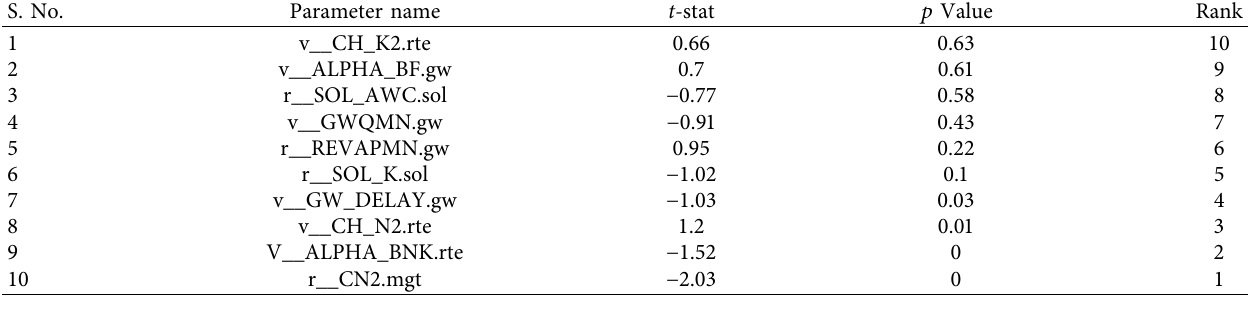
Table 7: Daily most sensitive parameters of the